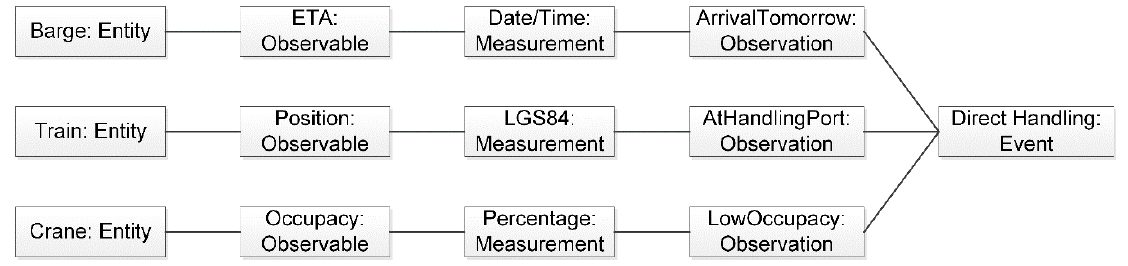
Figure 9. Exception “DirectHandling”.